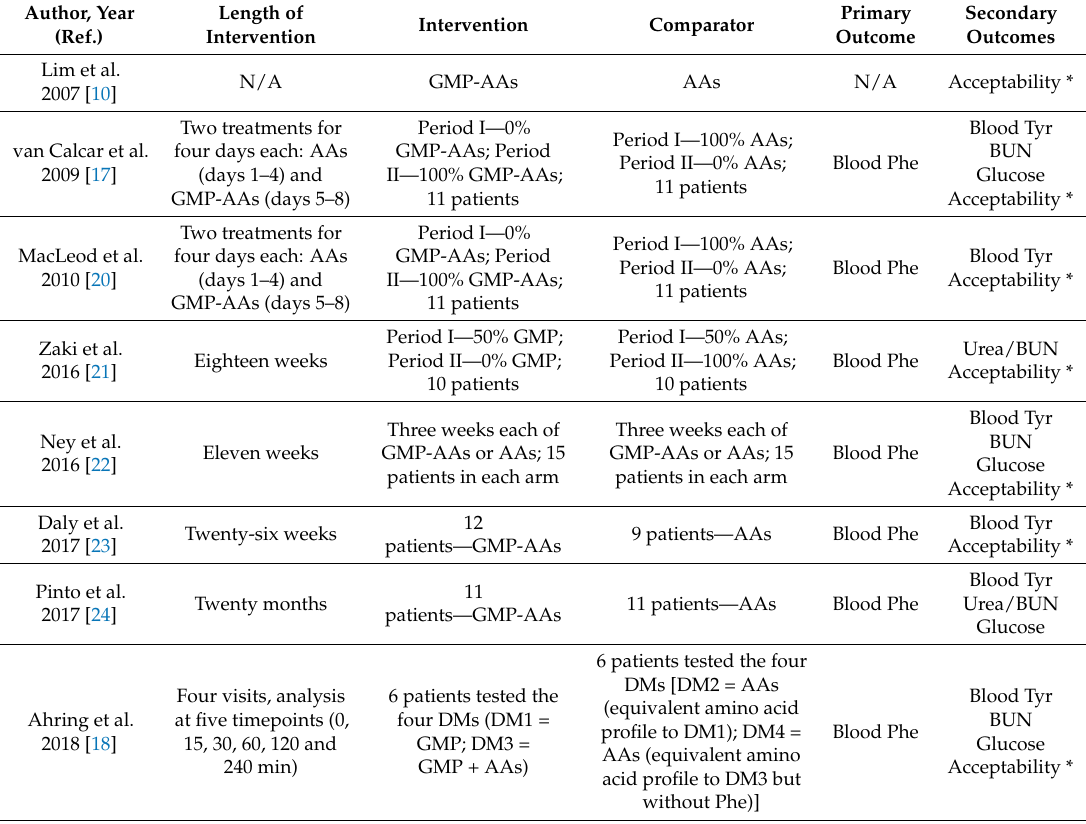
Table 2. Characteristics of treatment and outcome measures of the included